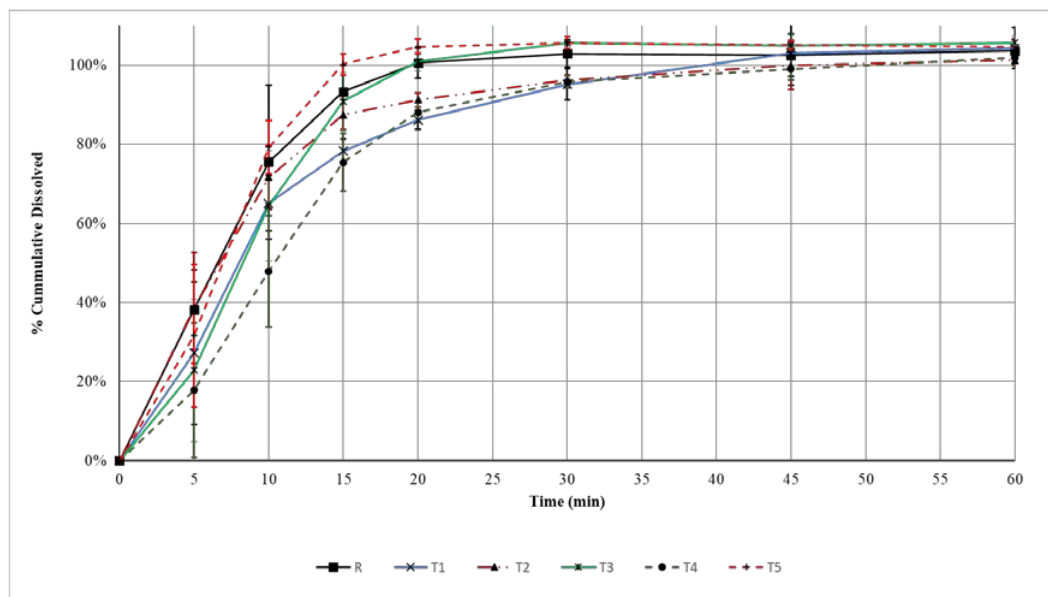
Figure 2. Dissolution profiles for amoxicillin trihydrate/potassium clavulanate tablets (1 G) from different brands available in local market. Error bars represent coefficient of variation (%).